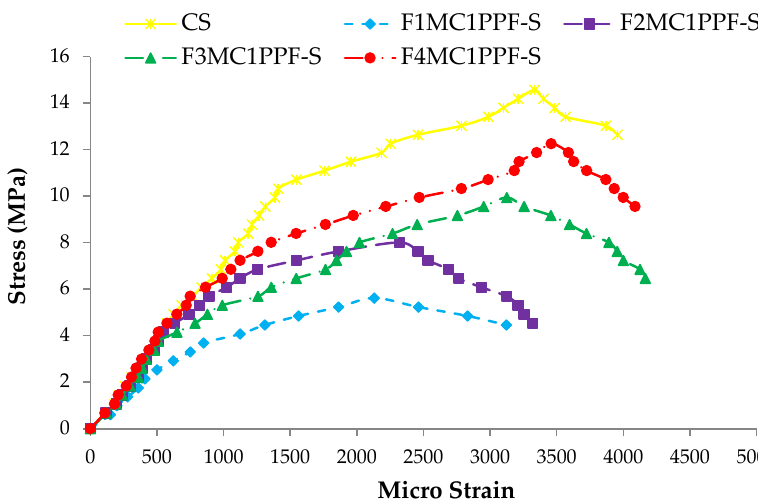
Figure 19. Comparison of flexure stress vs. strain of group B1 and CS slab.